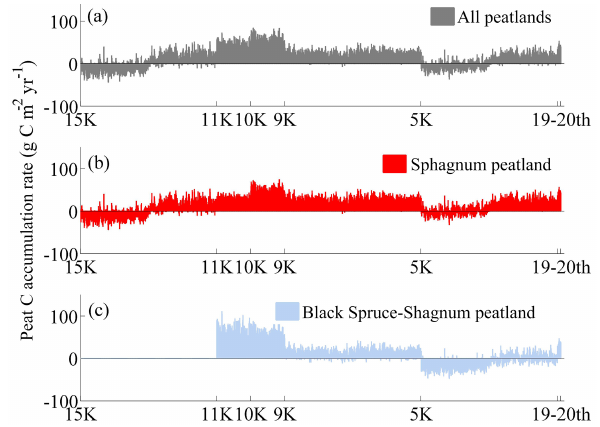
Figure 10. Bars of peatland mean C accumulation rates from 15ka to 2000AD for (a) the weighted average of all peatlands, (b) Sphag- num open peatlands, and (c) Sphagnum –black spruce peatlands.